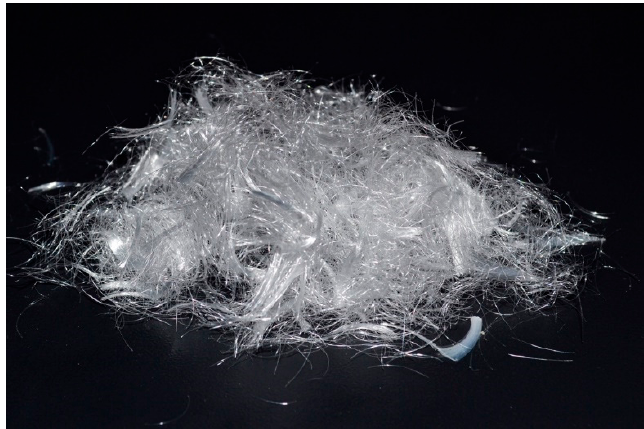
Figure 4. Polypropylene fiber (scale 1:1).